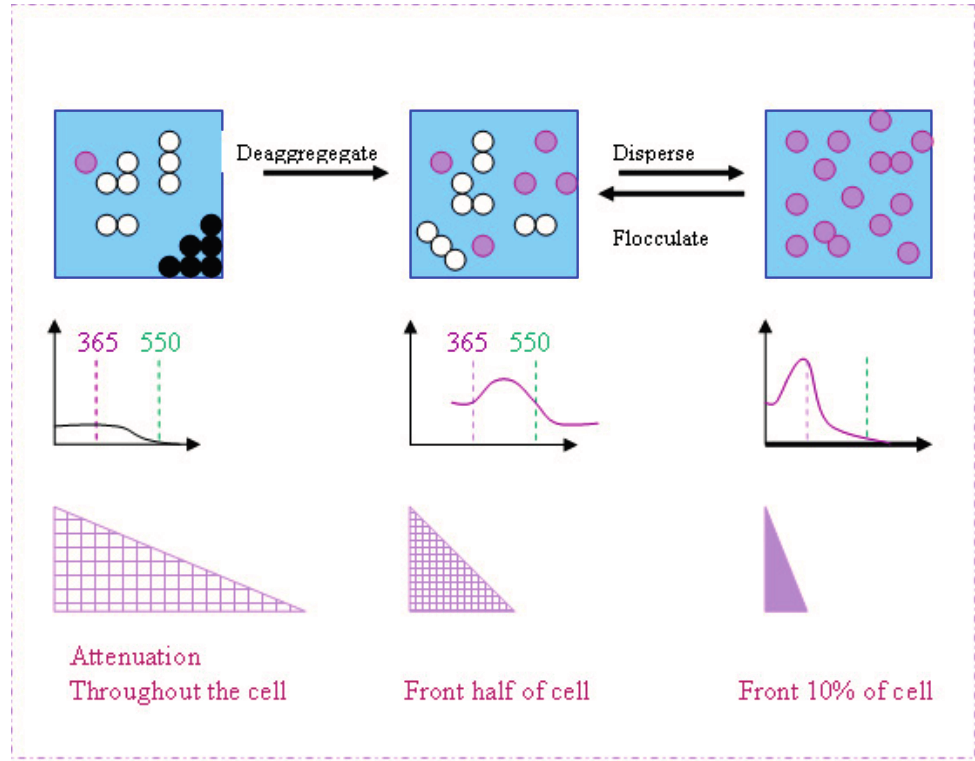
Figure 13. A schematic depiction of the effects of increased UV absorption associated with improved dispersion of TiO 2 particles. The second and third rows represent changes in the transmission spectrum and the attenuation of the incident UV beam as the particle dispersion is altered in the way depicted in the top